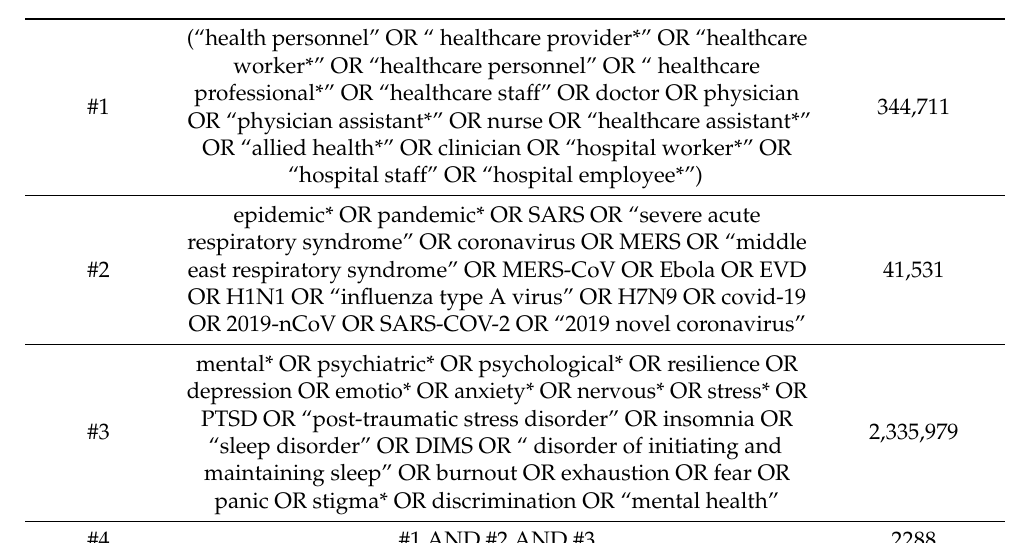
Table A3. PsycInfo